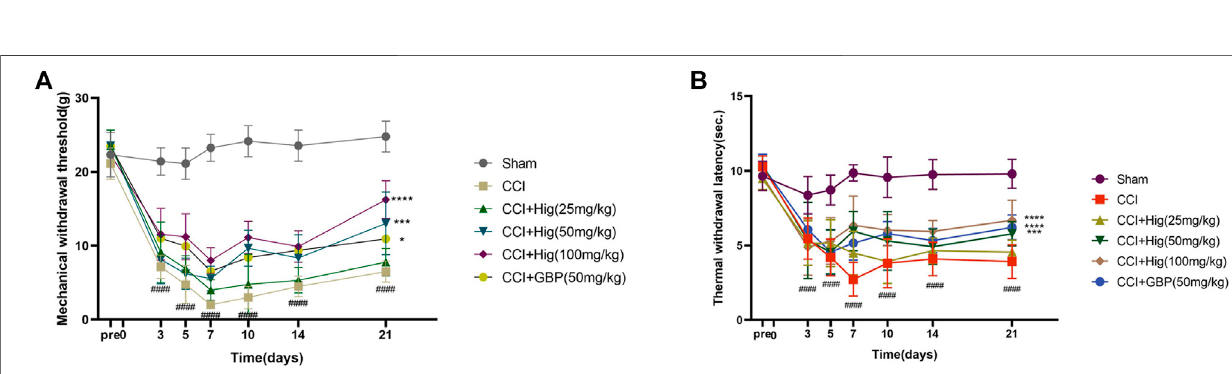
Frontiers in Pharmacology |